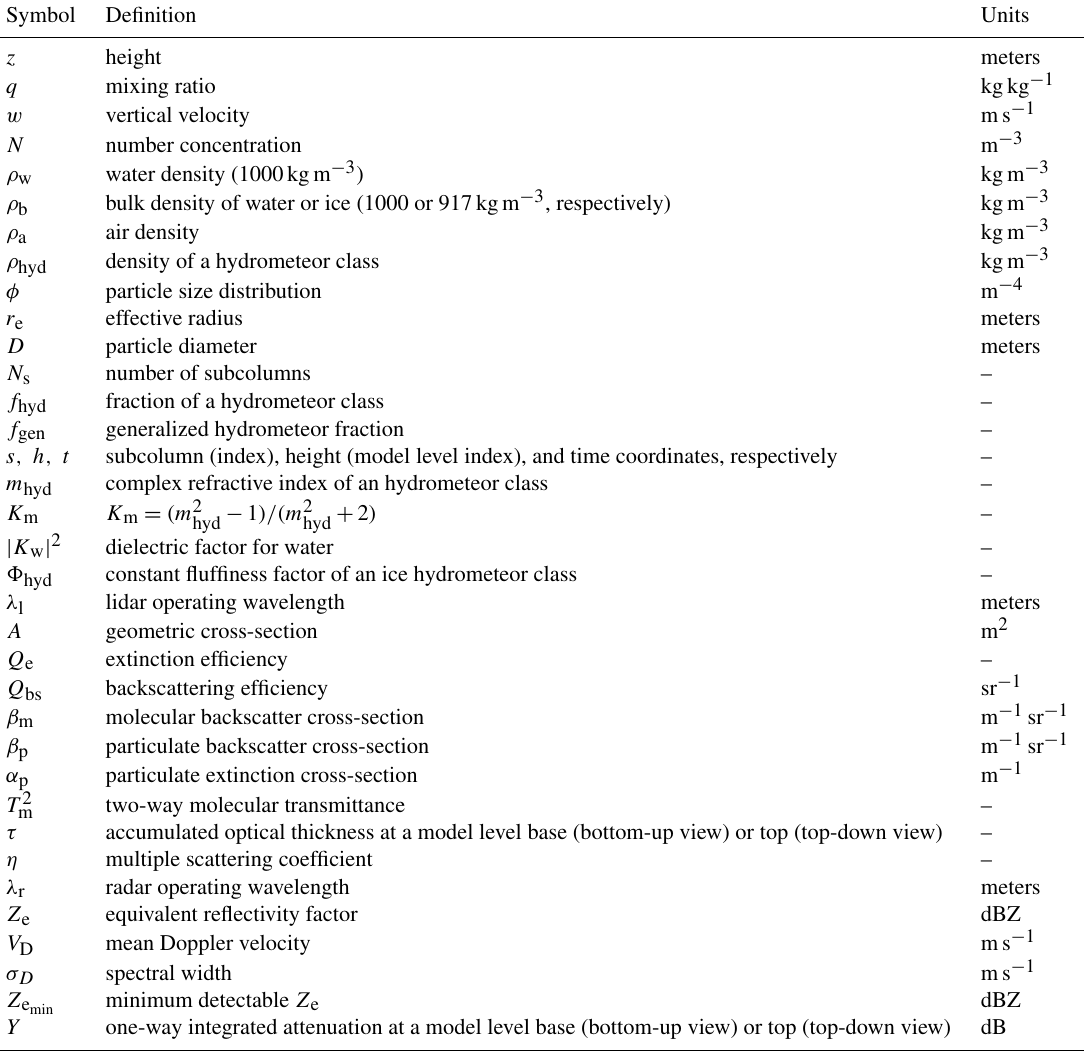
Table A2. Symbols of variables and parameters used in this article and their units (unless explicitly stated otherwise in the text).